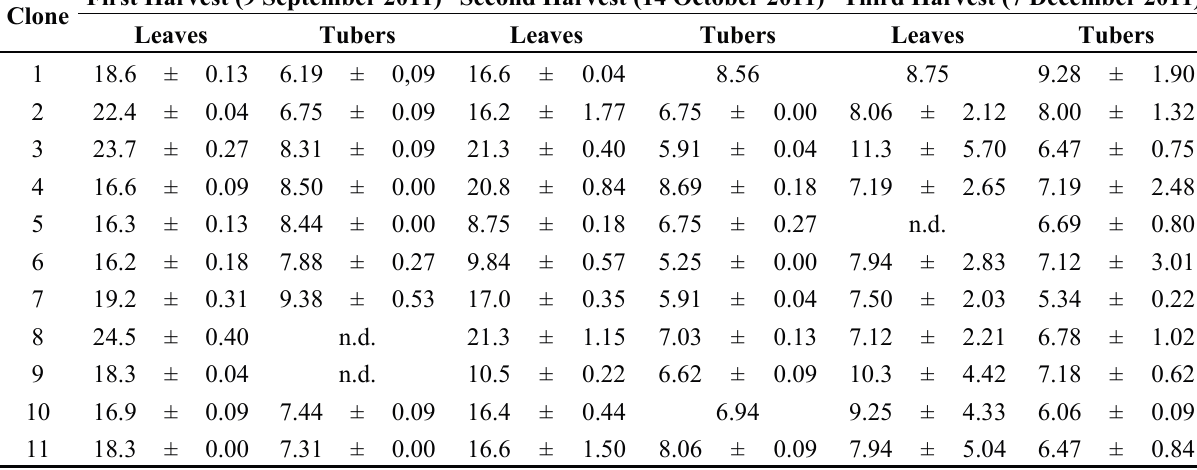
Table 1. Mean protein content (% of dry matter) measured by the Dumas method on a Flash 2000 NC Analyzer and applying a nitrogen conversion factor of 6.25 [35] in leaves and tubers of 11 different clones of Jerusalem artichoke harvested at three different occasions during the season. For description of the plant material see ref. [12].